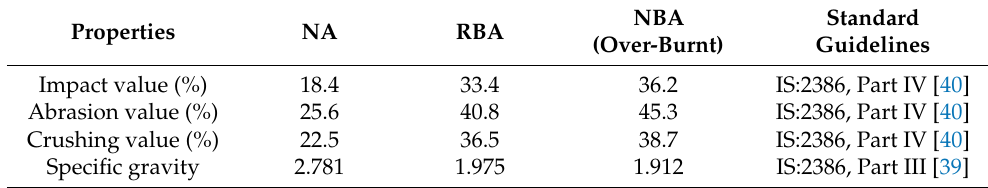
Table 2. General properties of RBA (standard specifications were followed from